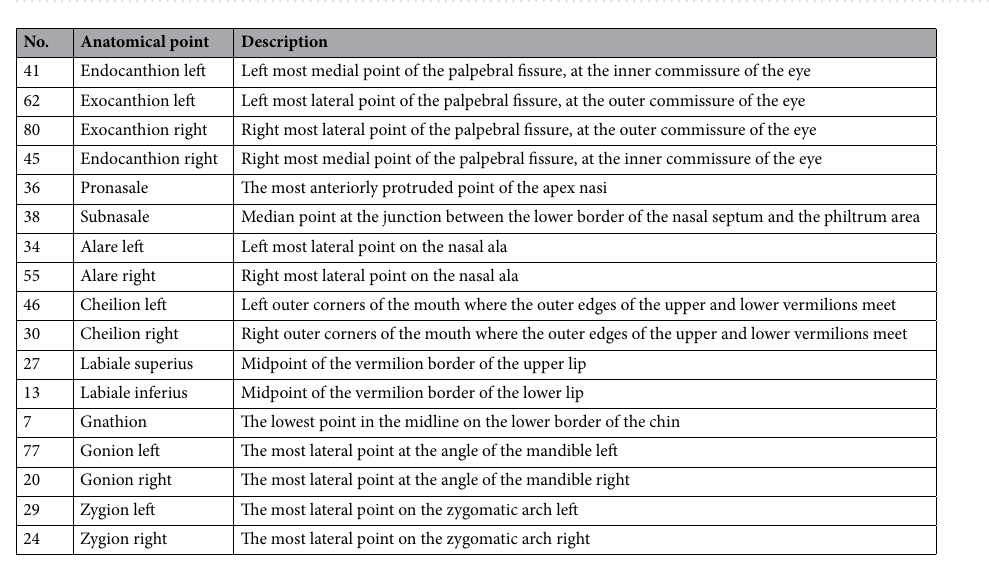
Figure 2. Facial landmarks and anthropometric measurements used in the study. ( A ) Shows an example of 83 automatically detected facial landmarks in green with the 17 anatomical landmarks in red while the number notation in light blue. ( B ) Approximate location of the 10 anthropometric linear distances used in the analysis redacted from 27 .